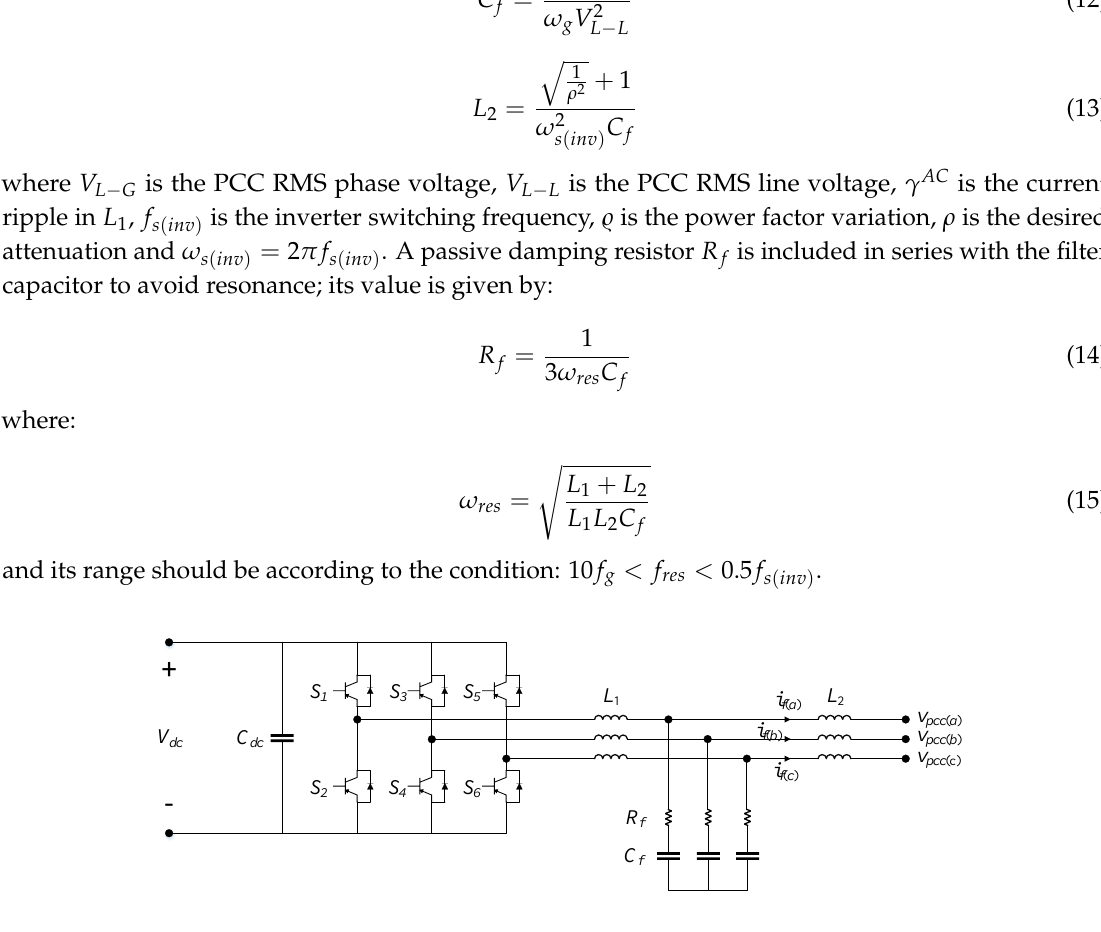
Figure 7. Four-quadrant converter circuit topology with LCL